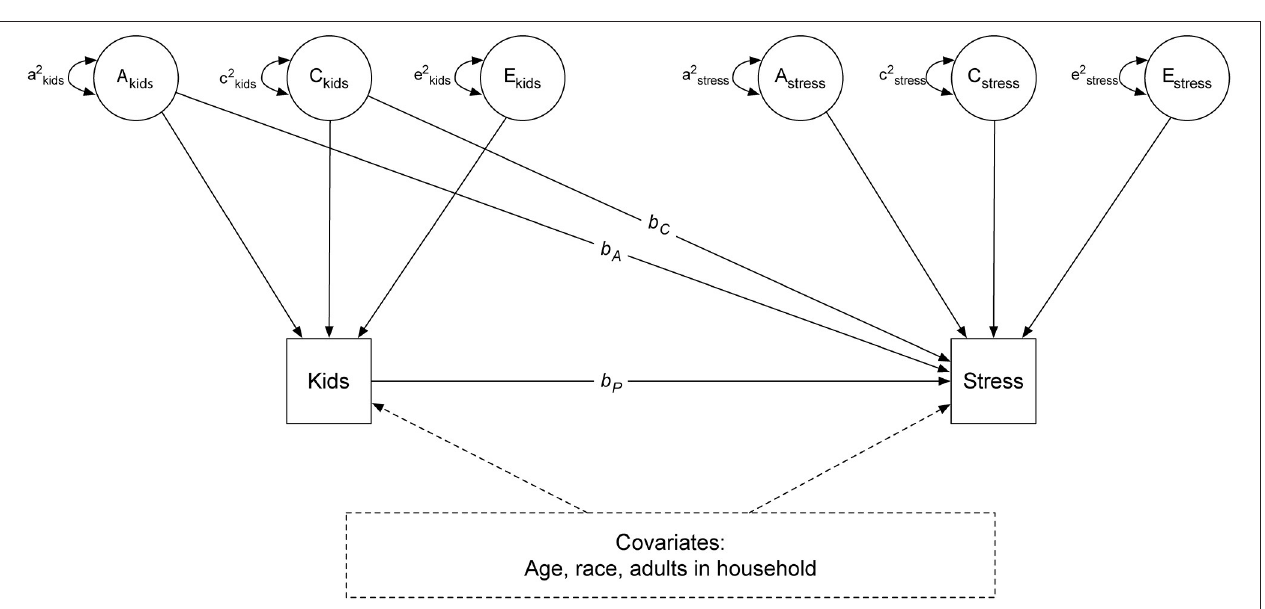
FIGURE 2 | Univariate twin model. A, additive genetic component; C, shared environmental component; E, unique environmental component. MZ, monozygotic twins; DZ, dizygotic twins.